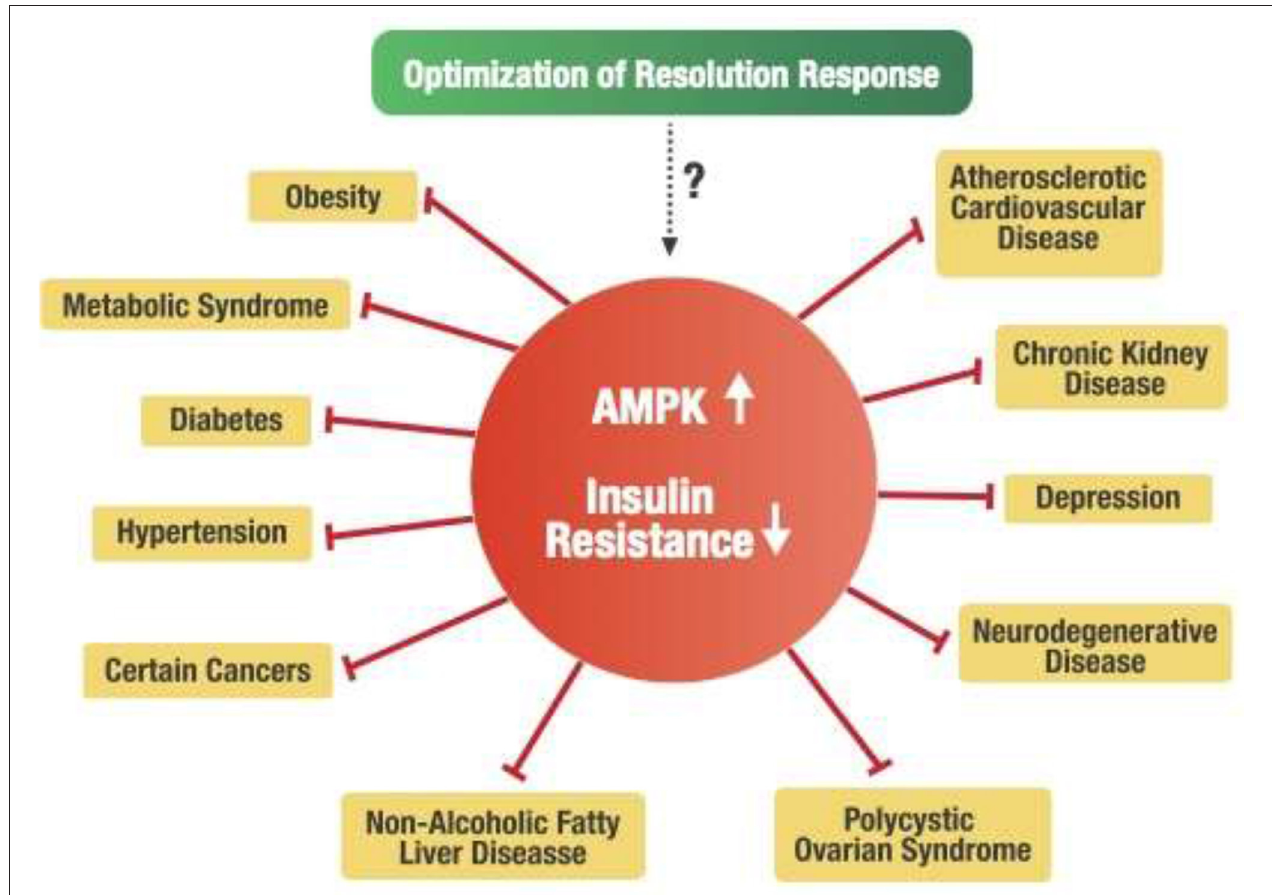
FIGURE 7 | Potential linkage of the Resolution Response to insulin resistance and related chronic disease